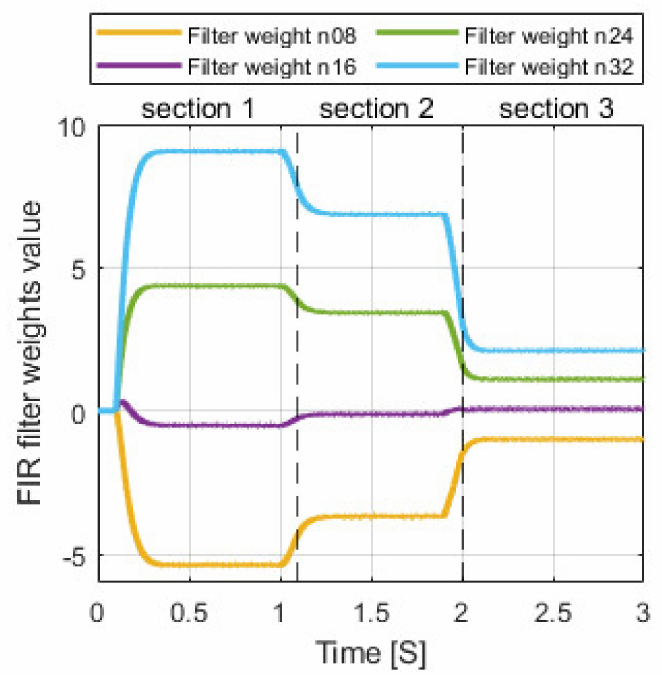
Figure 14. Simulation cycle 1: weight trend in FIR discrete filter.